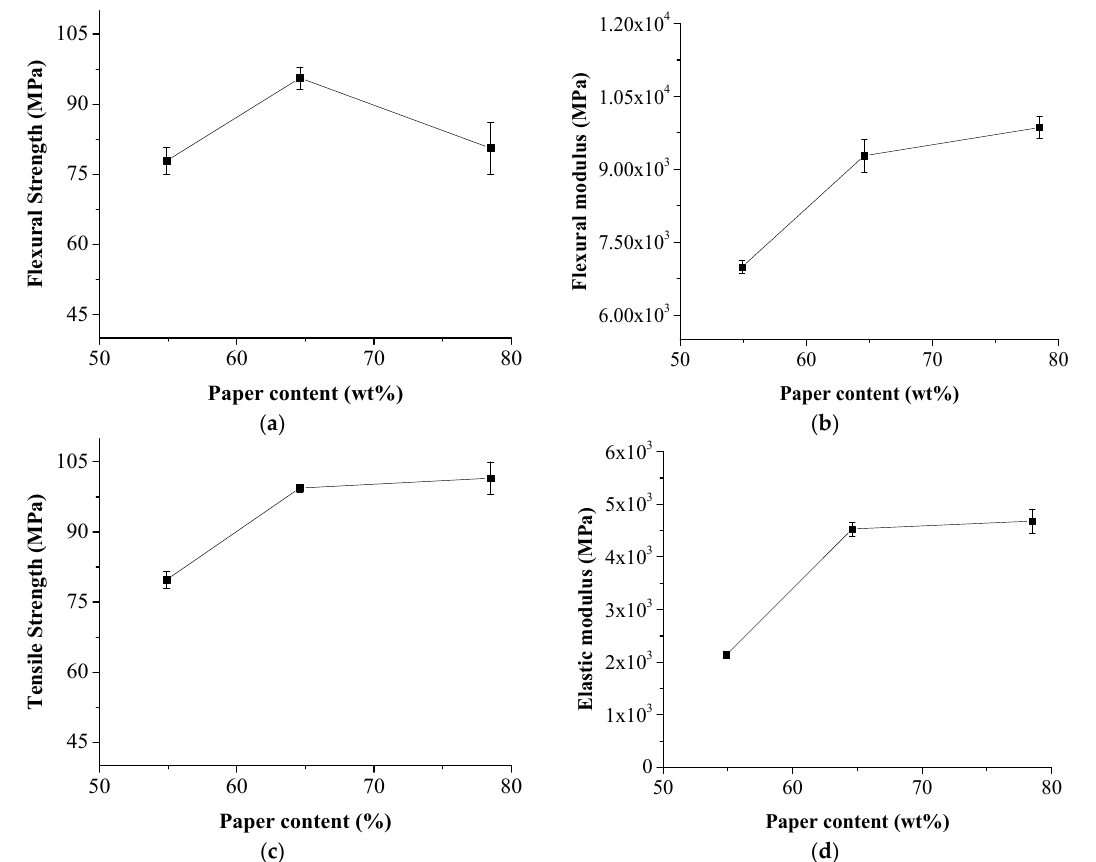
Figure 4. Effects of NP content on mechanical properties of the composite. ( a ) flexural strength; ( b ) flexural modulus; ( c ) tensile strength; ( d ) elastic modulus.